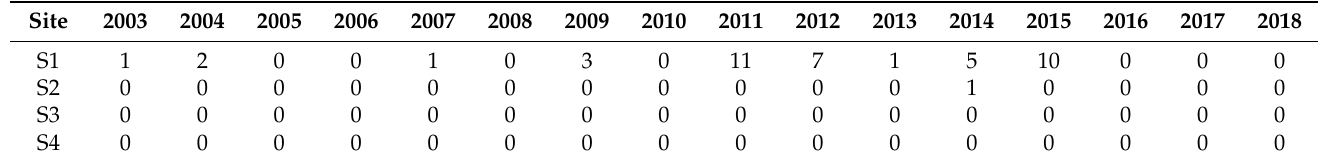
Table 3. The Number of the Occupational NIHL Cases Found at Study Sites from 1996 to